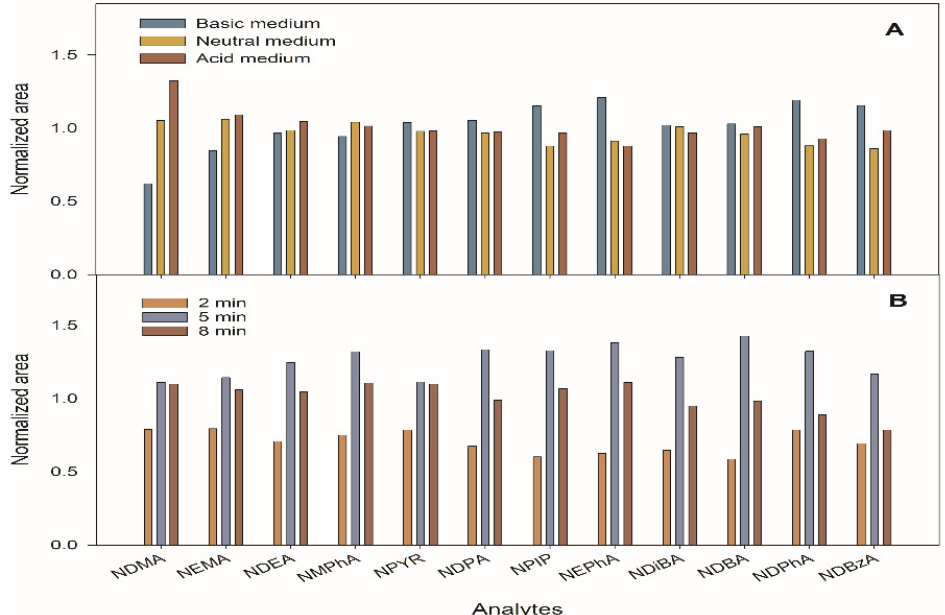
Figure 1. Influence of the nitrosamine (NA) extract medium ( A ) and the duration of ultrasounds treatment carried out by means of a probe ( B ) in the meat samples using ultrasound-assisted extraction (UAE).